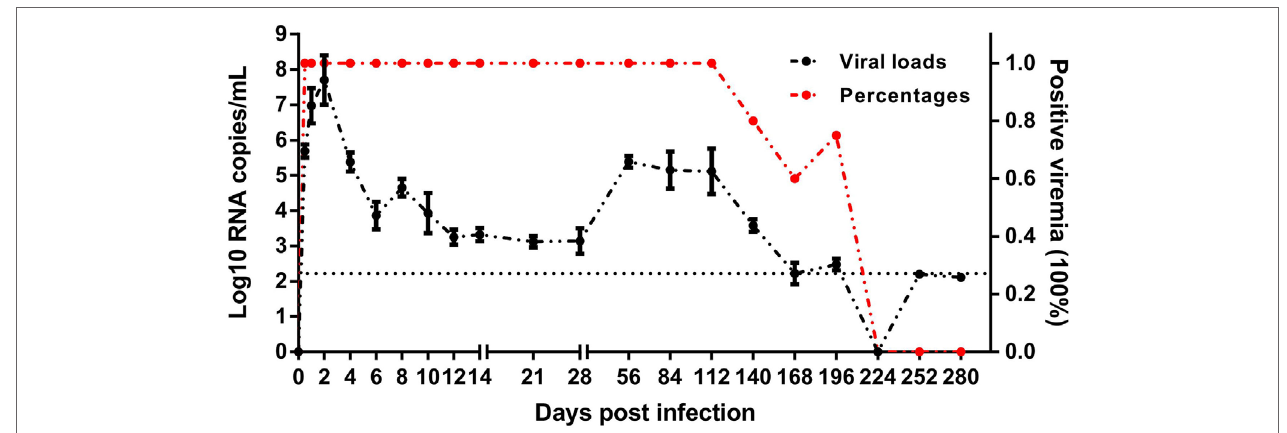
FigUre 1 | Course of duck hepatitis A virus 1 viremia (Log10 viral RNA copies/mL) in mature ducks after acute infection. The control group is shown as 0 dpi. Percentages represent the number of ducks with positive viremia. The number of ducks evaluated at each time point was 5, except for four ducks at 196 dpi. The dotted line represents the low limit of